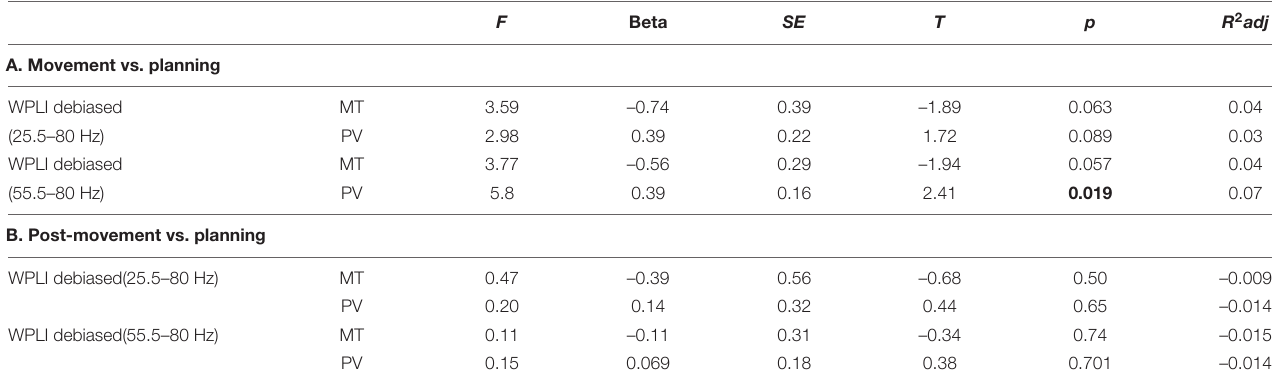
TABLE 3 | Linear regression models on the relationship between gamma phase-coherence and kinematic features. F Beta SE